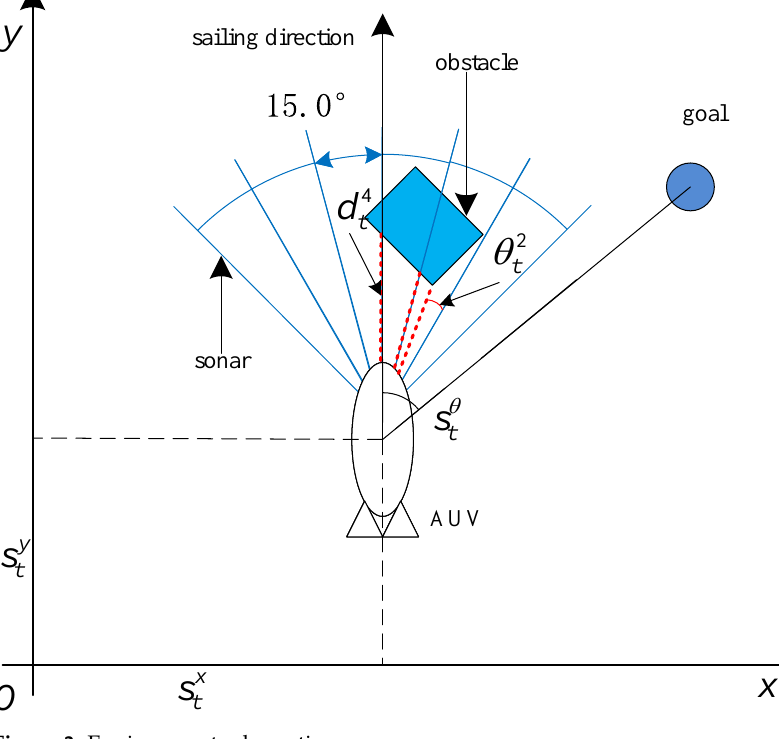
Figure 3. Environment